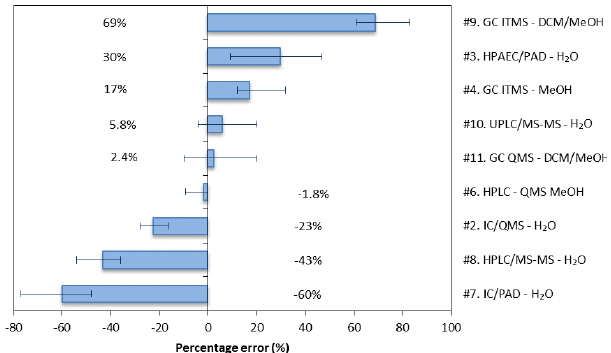
Figure 3: Calculated mean percentage error (PE) for each of the nine laboratories reporting levels of mannosan in the current intercomparison. The PE was calculated according to eq. 1 (Section 2.5) for each of the six sectors received by the participating laboratories. The mean PE for each laboratory accounts for the PE calculated for all six sectors. The laboratory number, ranging from 1-13, the analytical method and solvent used for extraction are mentioned at the right of the figure.